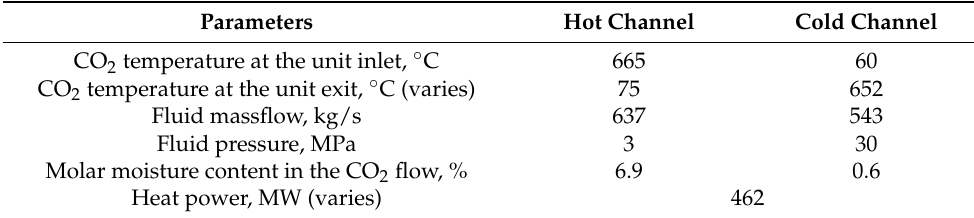
Table 3. Regenerator working parameters.